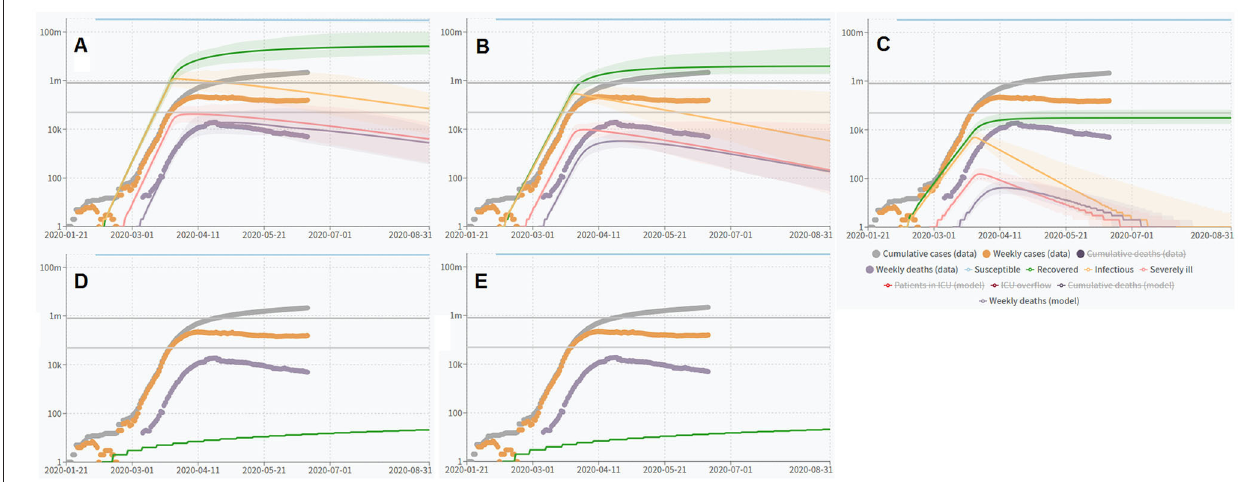
FIGURE 4 | The effect of masking the general public on the COVID-19 epidemic, as estimated using a simulation by COVID-19 Scenarios. (A) No mask, (B) 11% protection; (C) 39% protection, (D) 97.75% protection, and (E) 99.9991% protection.